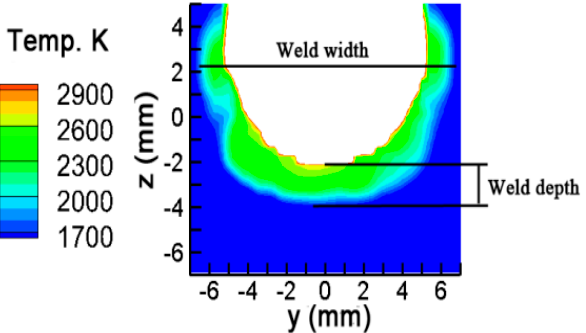
Figure 11. Comparison between simulated and experimental weld bead, experimental data from [6]. Table 3. Comparison between measured and predicted welds.